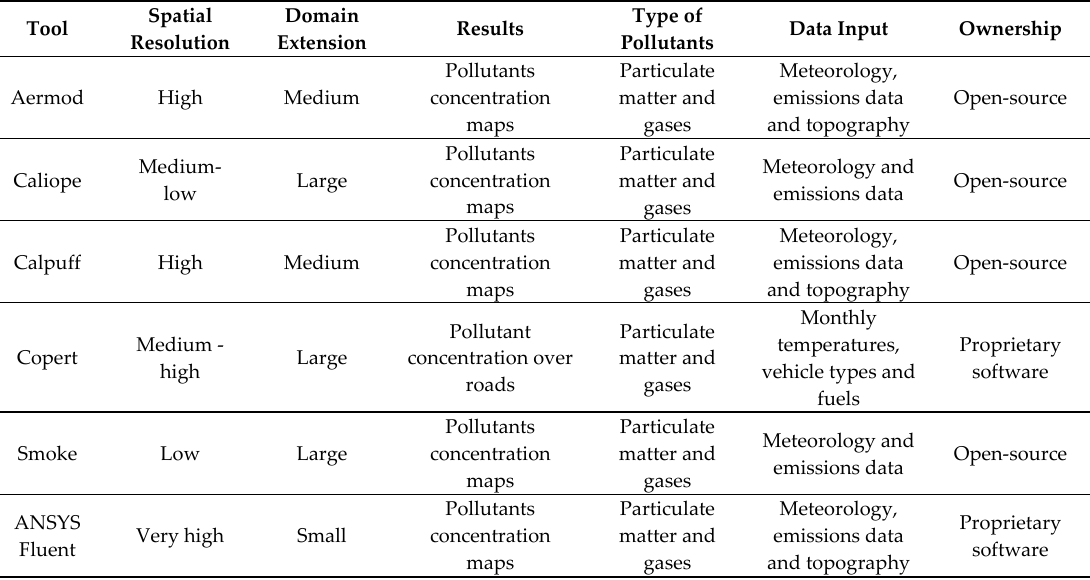
Table 1. Comparison between the different tools for air pollutant dispersion